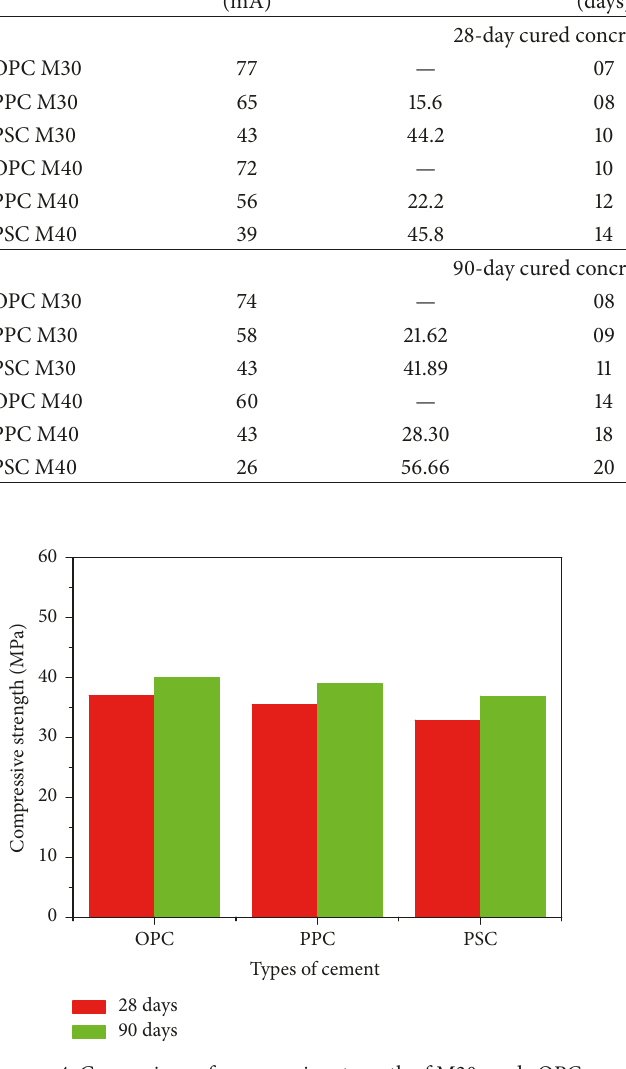
Figure 5: Comparison of compressive strength of M40 grade OPC, PPC, and PSC concrete